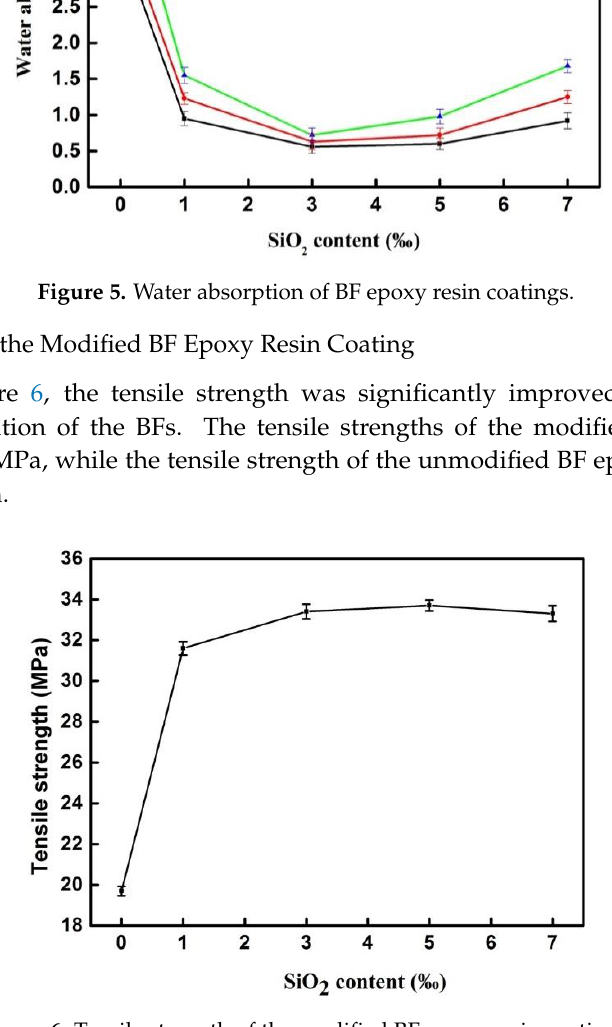
Figure 6. Tensile strength of the modified BF epoxy resin coatings.